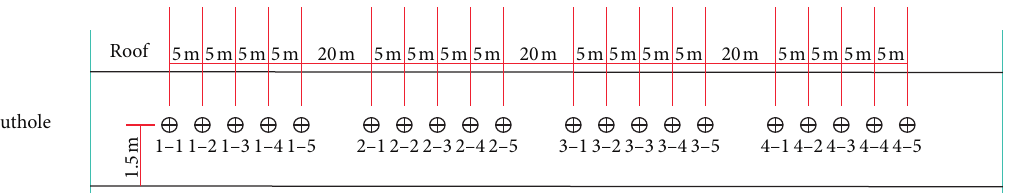
Figure 6: Diagram of hole sealing.